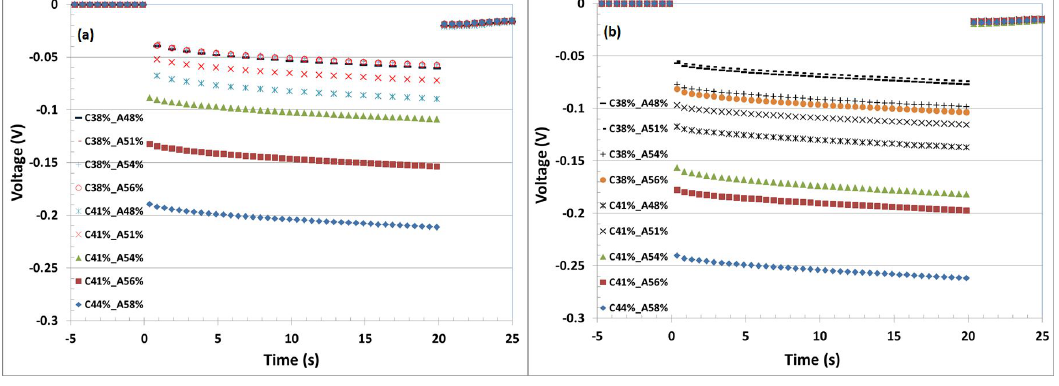
Figure 2. U ( t ) diagrams of discharge pulses at 3.7 V and at C/2 for 20 s: ( a ) after formation cycles; and ( b ) after 90 cycles.